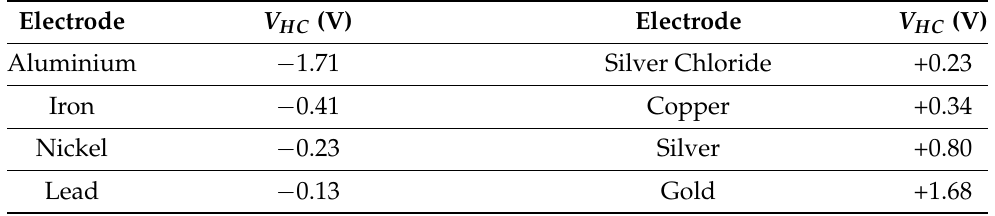
Table 2. Half-cell potential ( V HC ) of common electrodes under standard measurement conditions